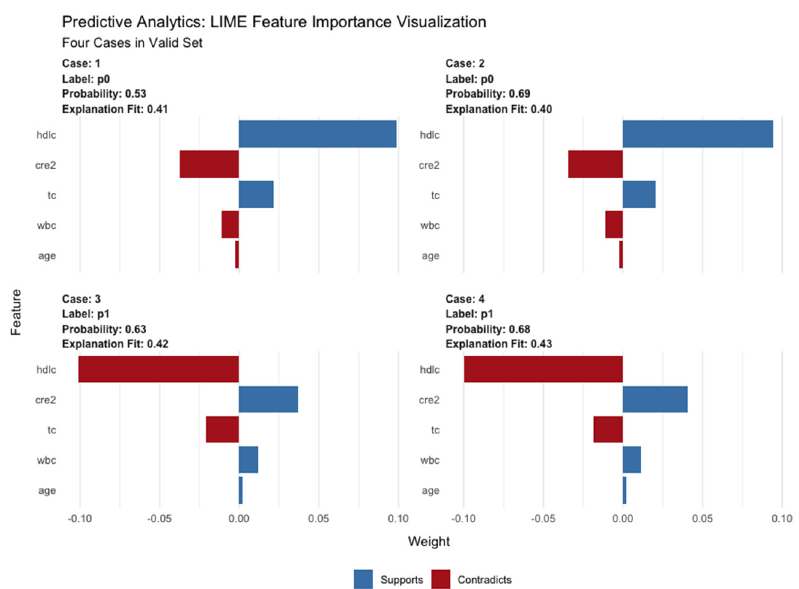
Figure 5. LIME of the XGBoost model in four cases from the validation set. The graph of LIME shows how the important variables (in the XGBoost model) contributed to mortality based on four selected samples (two from the survival group, two from the mortality group). Lable p0 means a survival sample, while lable p1 means a dead sample. Abbreviations: LIME, Local Interpretable Model Agnostic Explanation; hdlc, high-density lipoprotein cholesterol; cre2, creatinine; tc, total cholesterol; wbc, white blood cell count.